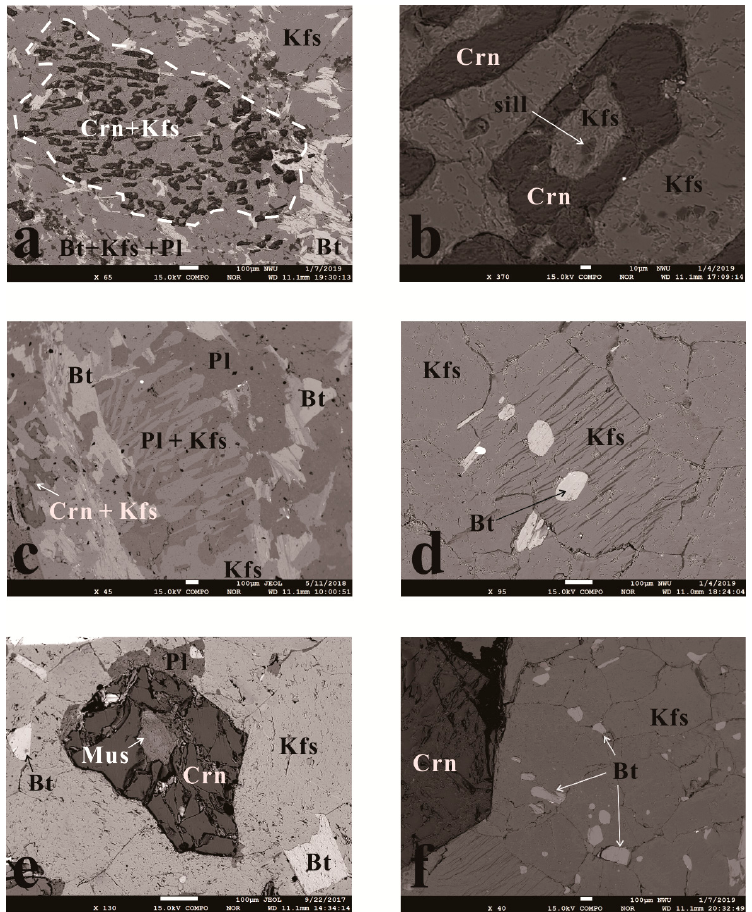
Figure 5. Back-scattered electron (BSE) images of mineral textures in the leucosome and mesosome.